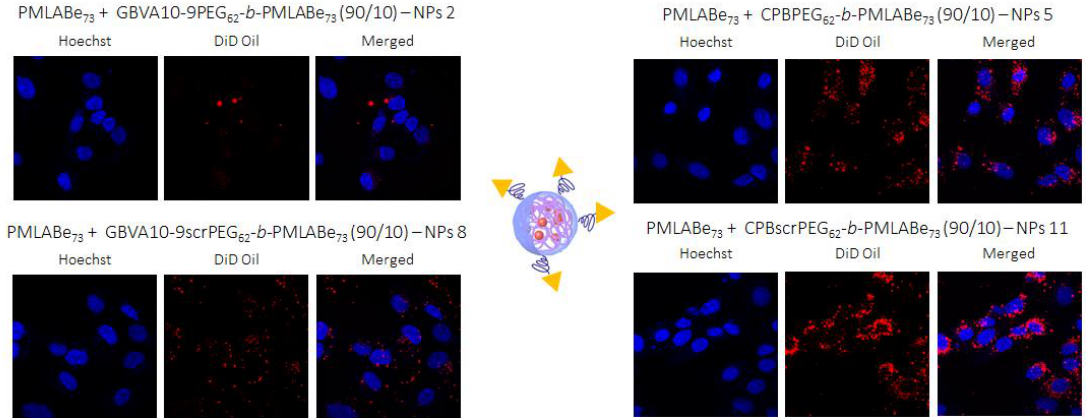
Figure 9. Images obtained by confocal microscopy.